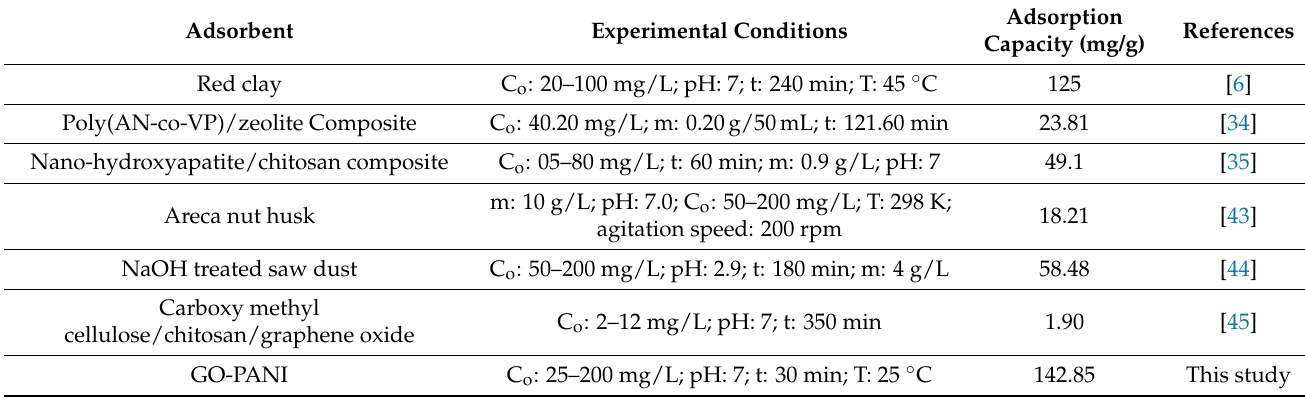
Table 3. Comparison of adsorption capacities of various absorbents used for BG removal.